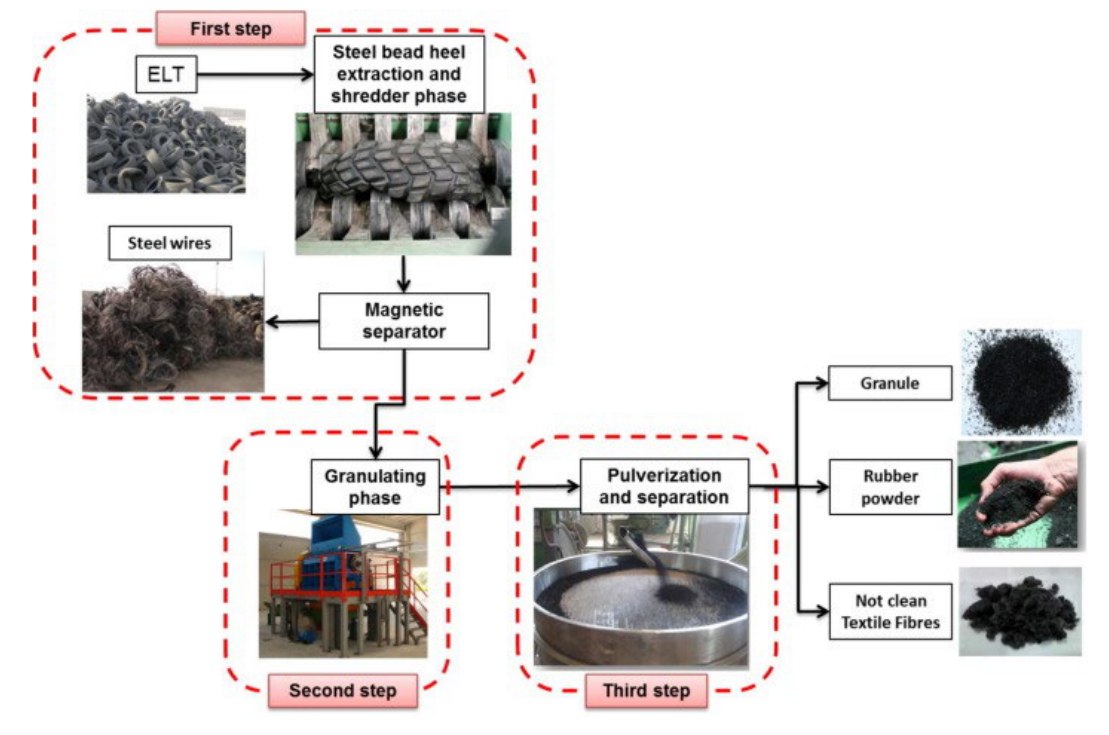
Figure 3. Different ELT disposal processes [10].